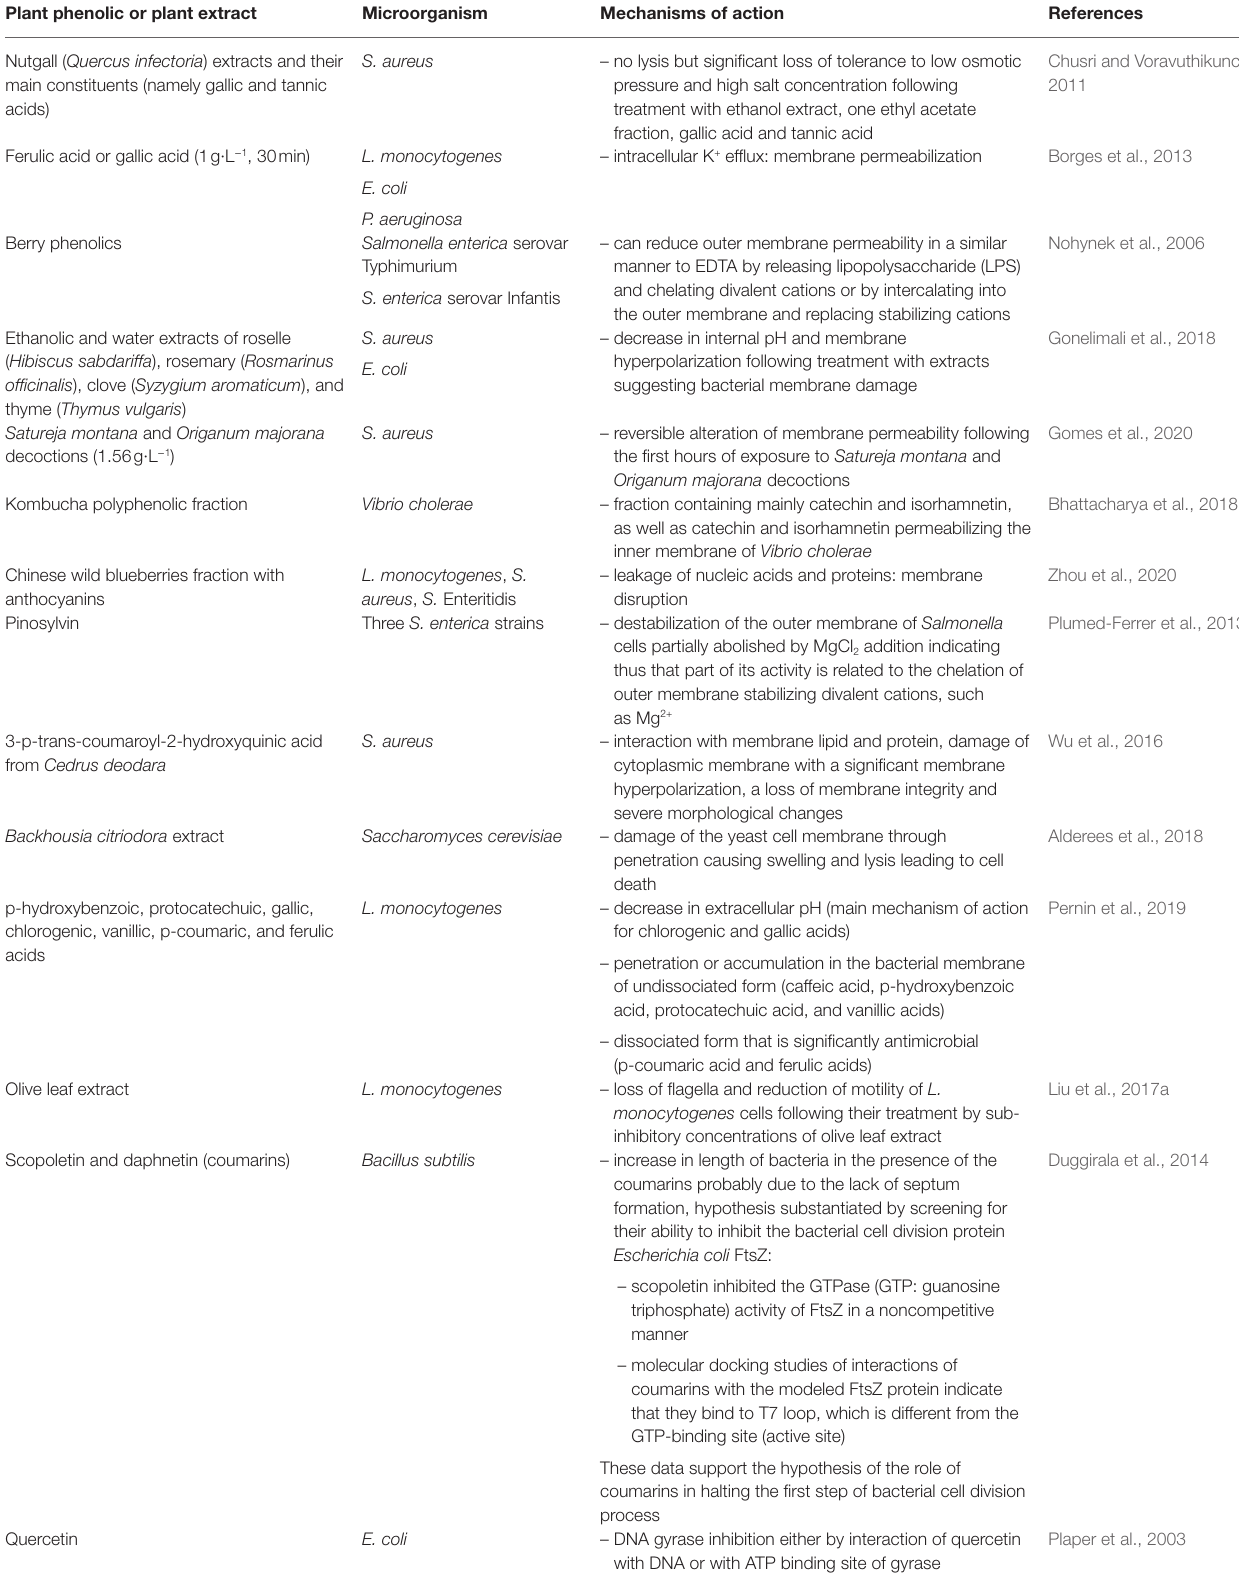
TABLE 2 | Examples of plant phenolics or phenolic-rich plant extracts with different antimicrobial mechanisms of action. Plant phenolic or plant extract